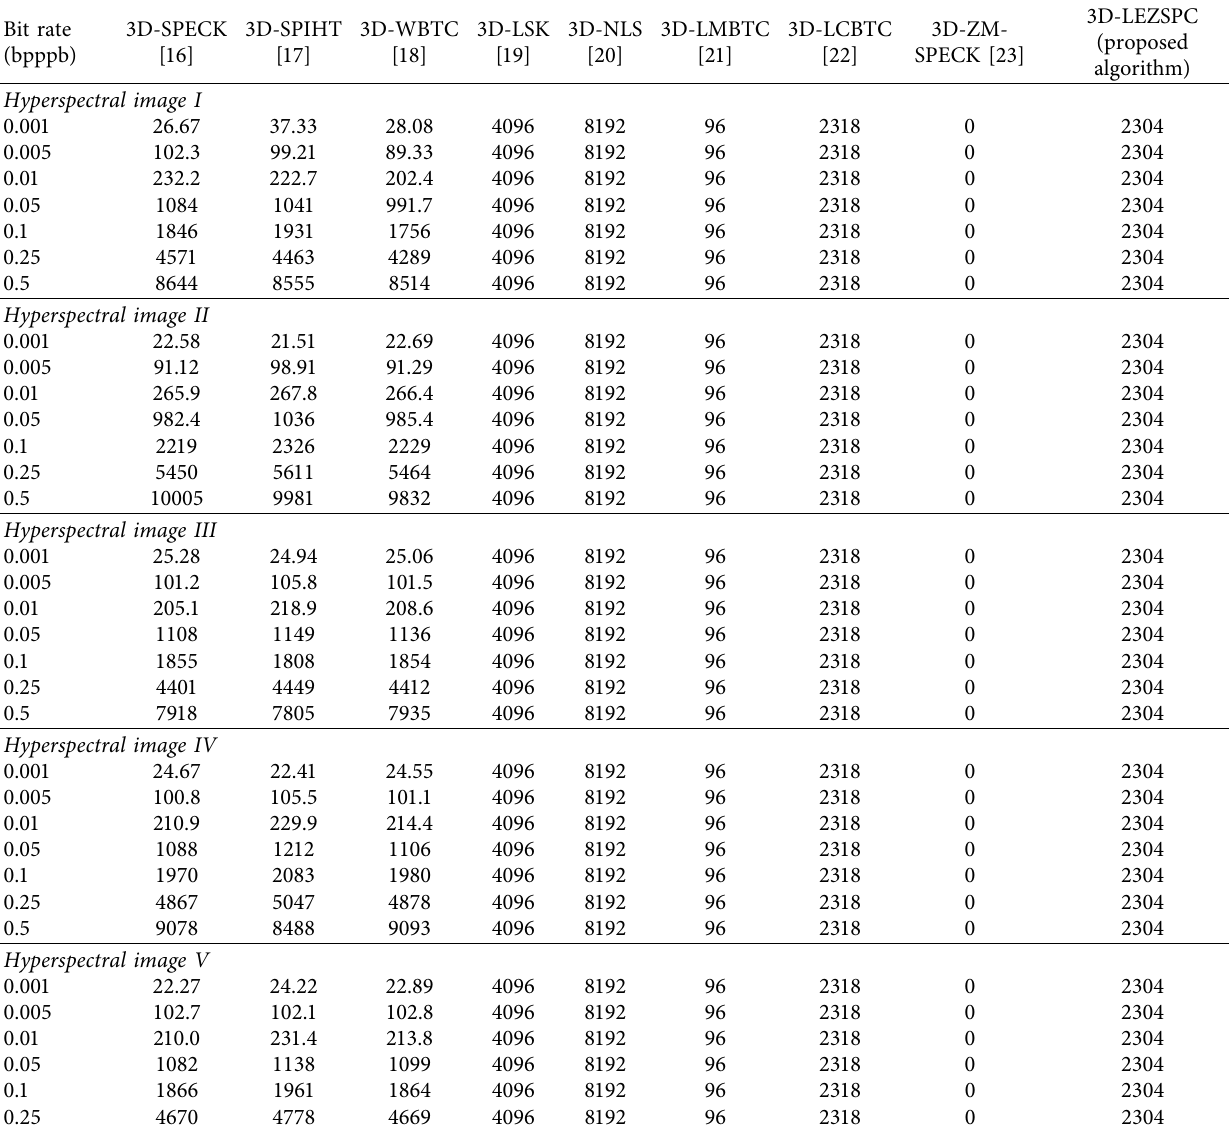
Table 7: Coding memory requirement (in kB) between the 3D-LEZSPC with the other wavelet transform based set partitioned